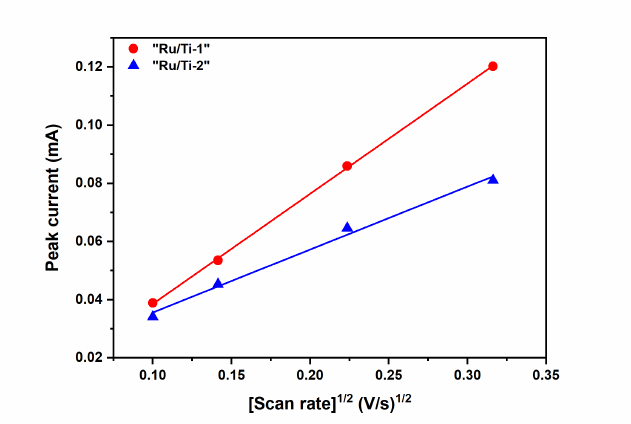
Figure 23. Peak current as a function of the square root of the scan rate for cyclyc voltammograms obtained in a solution containing 1 mM K 4 [ Fe ( CN ) 6 ] in 0.1 M KOH. A higher slope indicates a higher electroactive surface